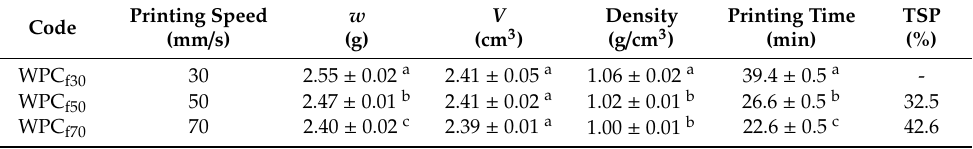
Table 2. Density and printing time of flexural WPC parts printed at various printing speeds.